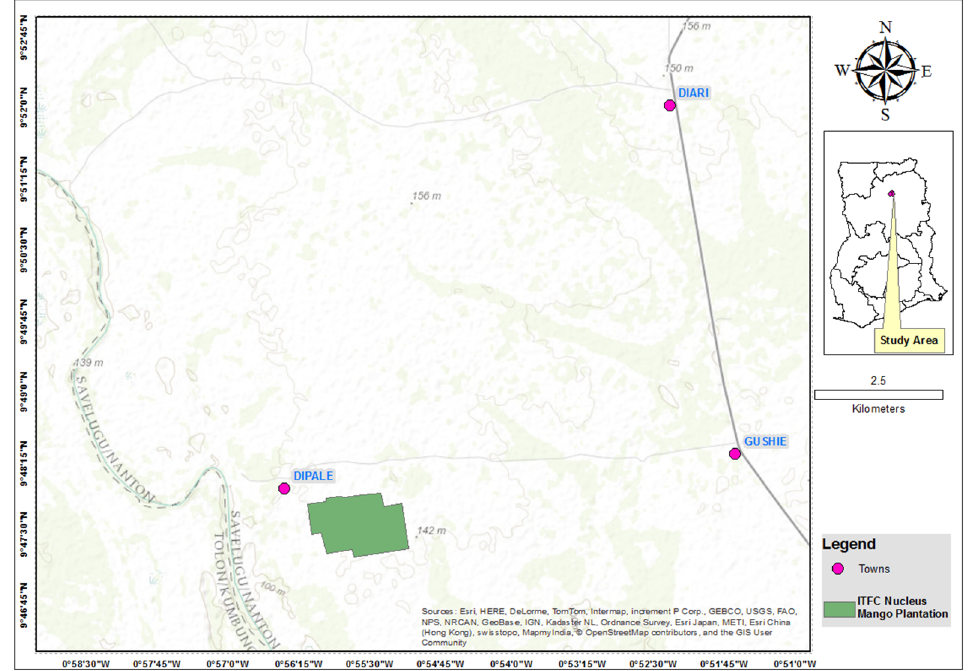
Figure 2. ITFC project showing some focus communities in the Savelugu-Nanton District. Source: Own